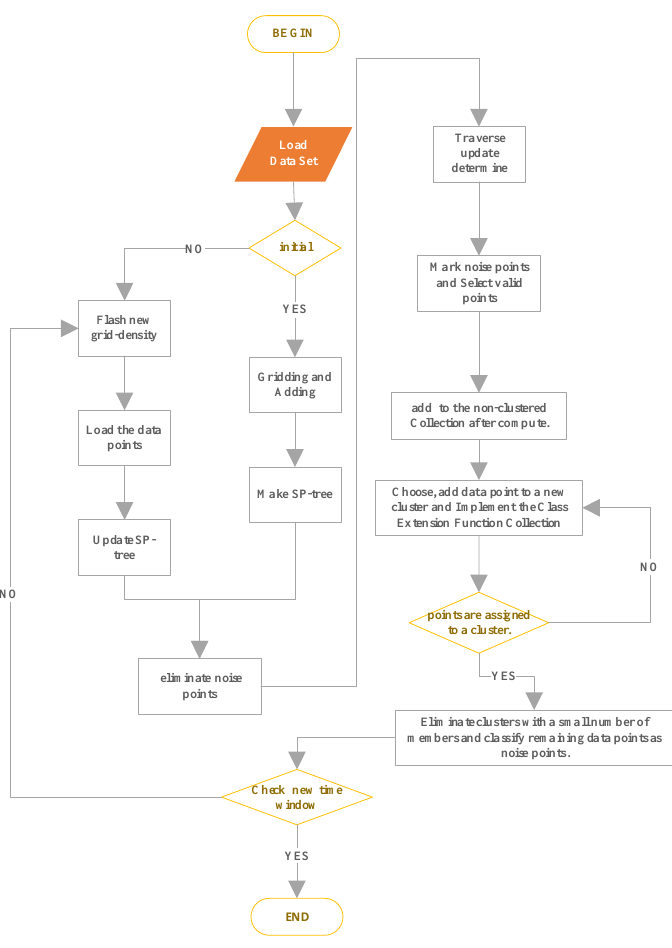
Figure 7. MDDSDB-GC algorithm flow chart.